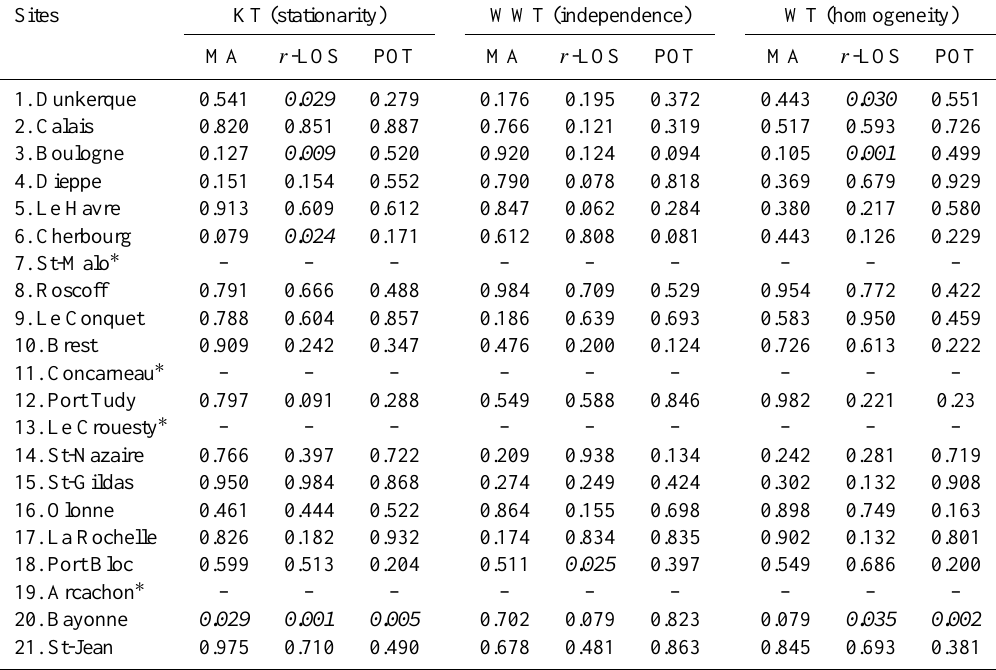
Table 1. Stationarity, independence and homogeneity tests ( p value).